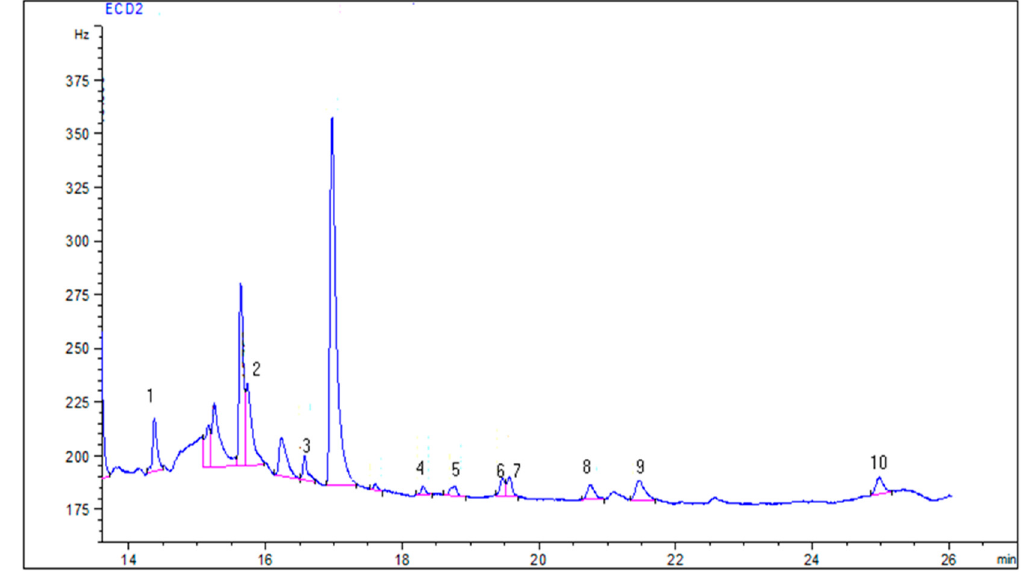
Figure 3. Representative Chromatogram and peaks identification of pesticides in surface water samples from Charsadda area: (1) γ -BHC, (2) heptachlor, (3) aldrin, (4) α -chlordane, (5) endosulfan I, (6) 4,4 ′ -DDE, (7) dieldrin, (8) endosulfan II, (9) Endrin aldehyde, (10) Endosulfan sulfate. Table 4. Summary of selected pesticides contamination in surface water samples of Charsadda area.